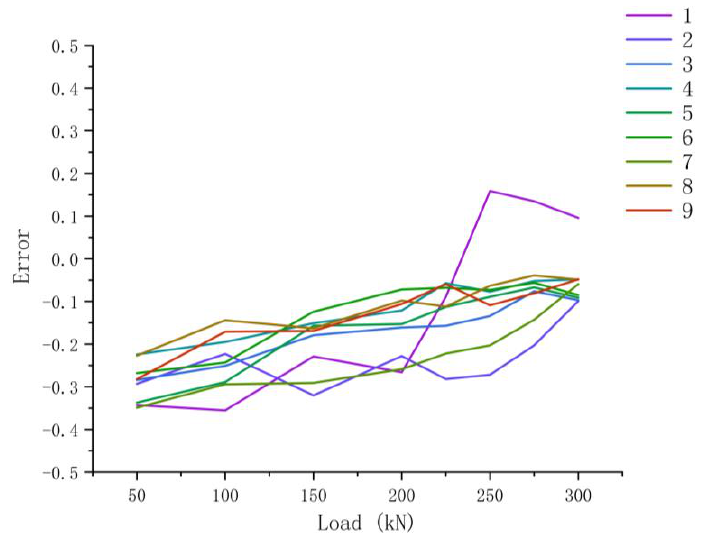
Figure 30. Error diagram of test and simulation.